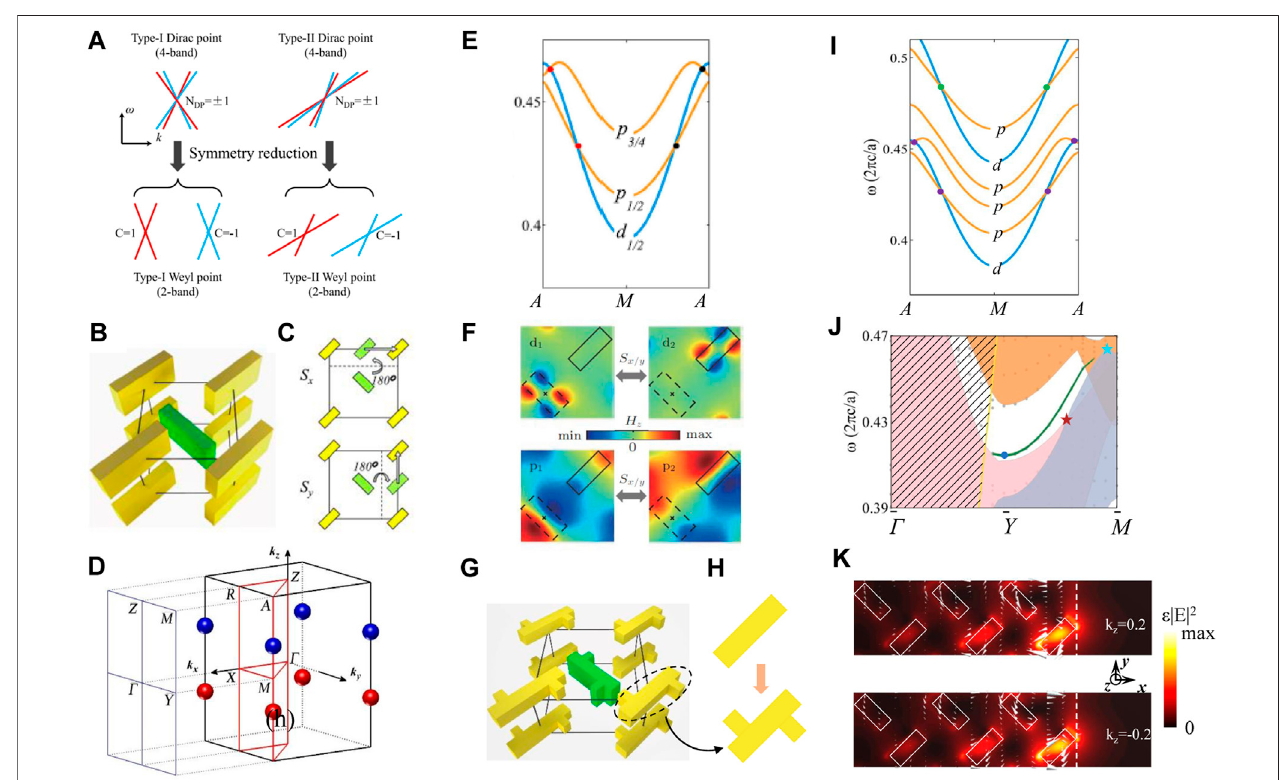
FIGURE 8 | Photonic topological semimetals [171]. (A) Relationship between type-I/type-II Dirac points and Weyl points. (B) Three-dimensional structure of a unit cell,wheretheboundariesareindicatedbyblacklines. (C) Illustrationofthetwoscrewsymmetry S x and S y intop-downview. (D) ThebulkandsurfaceBrillouinzone,with thedistributionoftheDiracpoints. (E) Parityinversioninducedtype-Iandtype-IIDiracpointsontheMAline. (F) Magnetic fi eldpro fi lesofthe p -and d -wavedoublets, p 1 / 2 and d 1 / 2 , respectively. The doubly degenerate states are connected by the screw symmetries. (G) Unit cell structure of the symmetry-broken PhCs. (H) Three- dimensionalviewwithzoom-inillustrationofstructuredeformations. (I) BandstructureontheMAlineforpartofthe fi rstsixphotonicbandsindicates,whichthecrossings are identi fi ed as type-I and type-II Weyl points. (J) Surface band and projected bulk band on PhC – air surface. (K) Energy density and Poynting vector pro fi les for the topological surface states at two opposite wavevectors. Reproduced permission from Ref. 171.